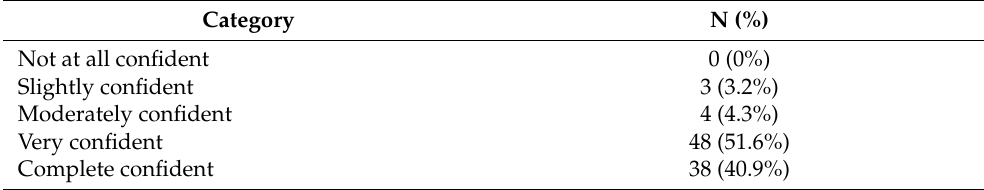
Table 3. Rate for self-perceived difficulty in